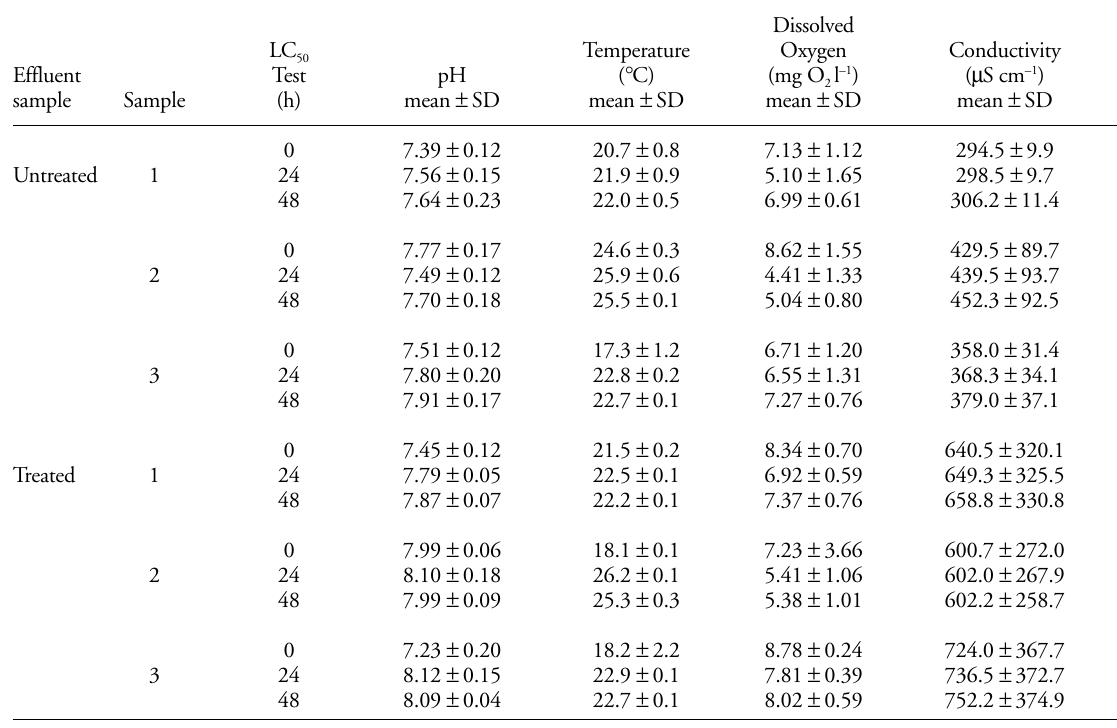
Table 2. Water variables determined during the exposure